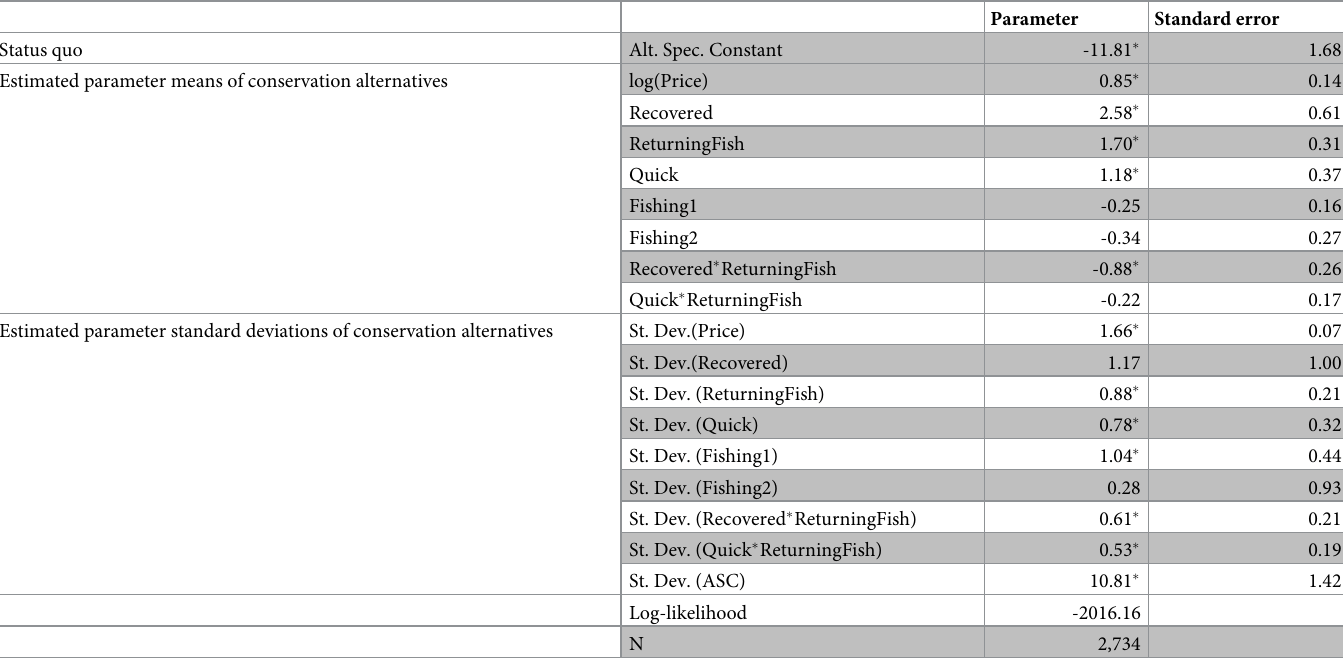
Table 1. Random parameters logit estimation results for preferred